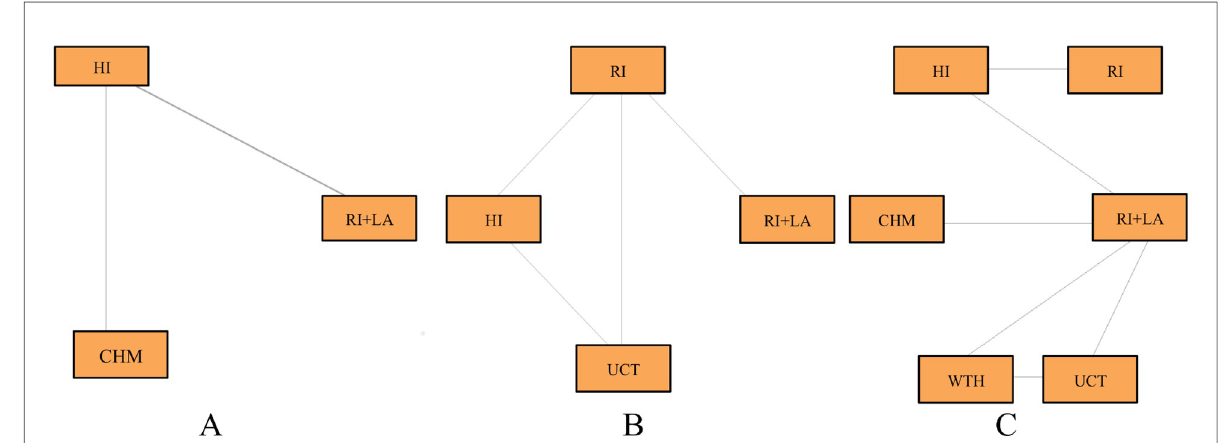
Fig 3. Network of the comparisons of restorative treatments in primary teeth. The width of lines connecting each pair of treatment is proportional to the number of studies regarding anxiety (A), quality of life (B) and pain (C).